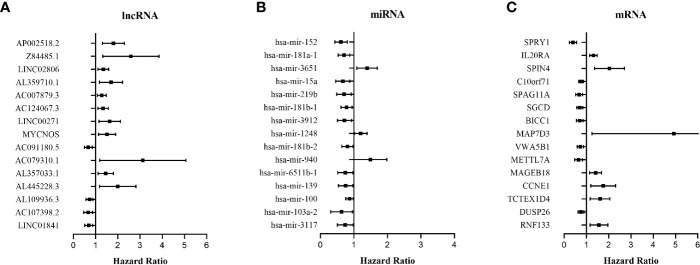
Forest plots of the hazard ratios (HR) of the survival-associated RNAs in WT. (A) HR of top 15 survival-associated lncRNAs. (B) HR of top 15 survival-associated miRNAs. (C) HR of top 15 survival-associated mRNAs. HR <1 indicates the protective RNAs, and HR >1 indicates the risk RNAs.